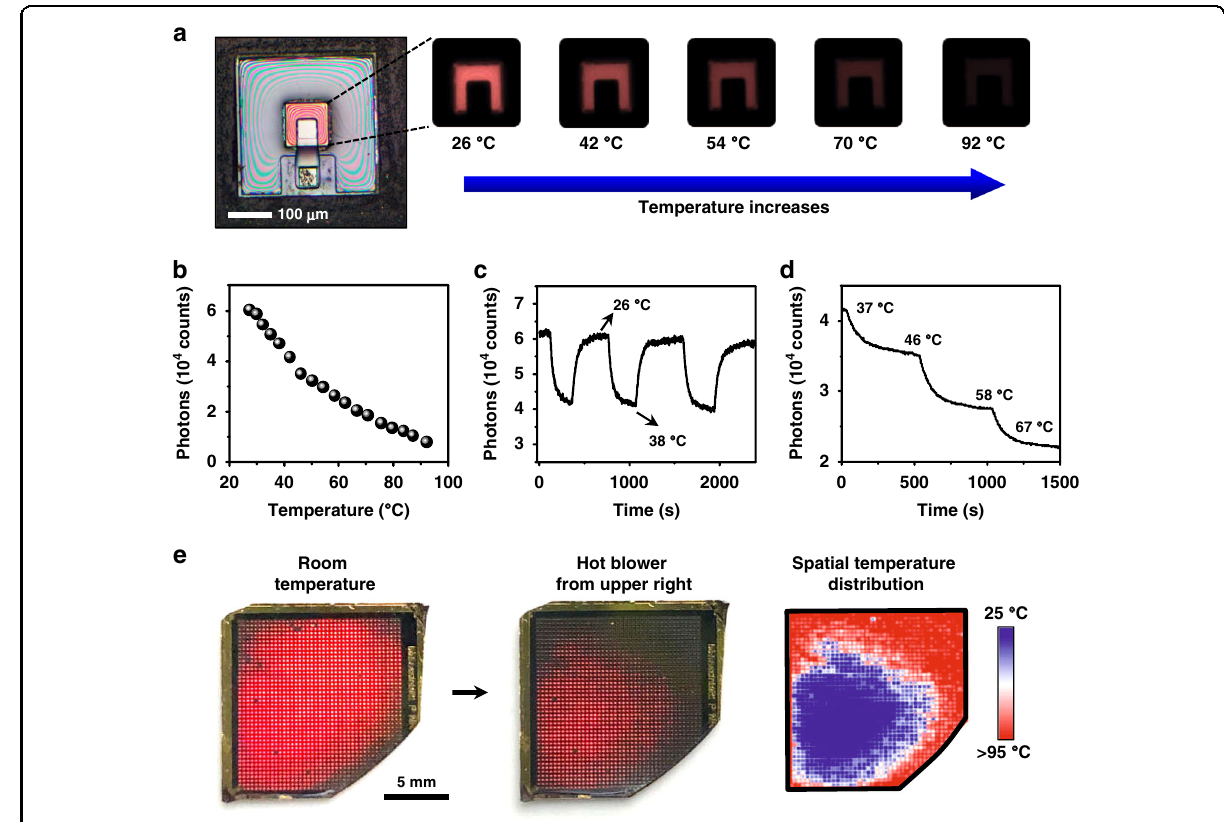
Fig. 3 Dynamic thermal sensing and mapping based on the upconversion devices. a Microscopic images show PL emissions of an optoelectronic upconversion device, with the intensity changing with the temperature from 26 °C to 92 °C. b Relation of PL intensity versus temperature. c Cycled temperature test of the device repeatedly changes from 26 °C to 38 °C. d PL intensity of the device responding to step-tuned temperature changes. e Spatially resolved PL responses of a device array at room temperature (left) and under nonuniform heating (middle). Right: the corresponding temperature